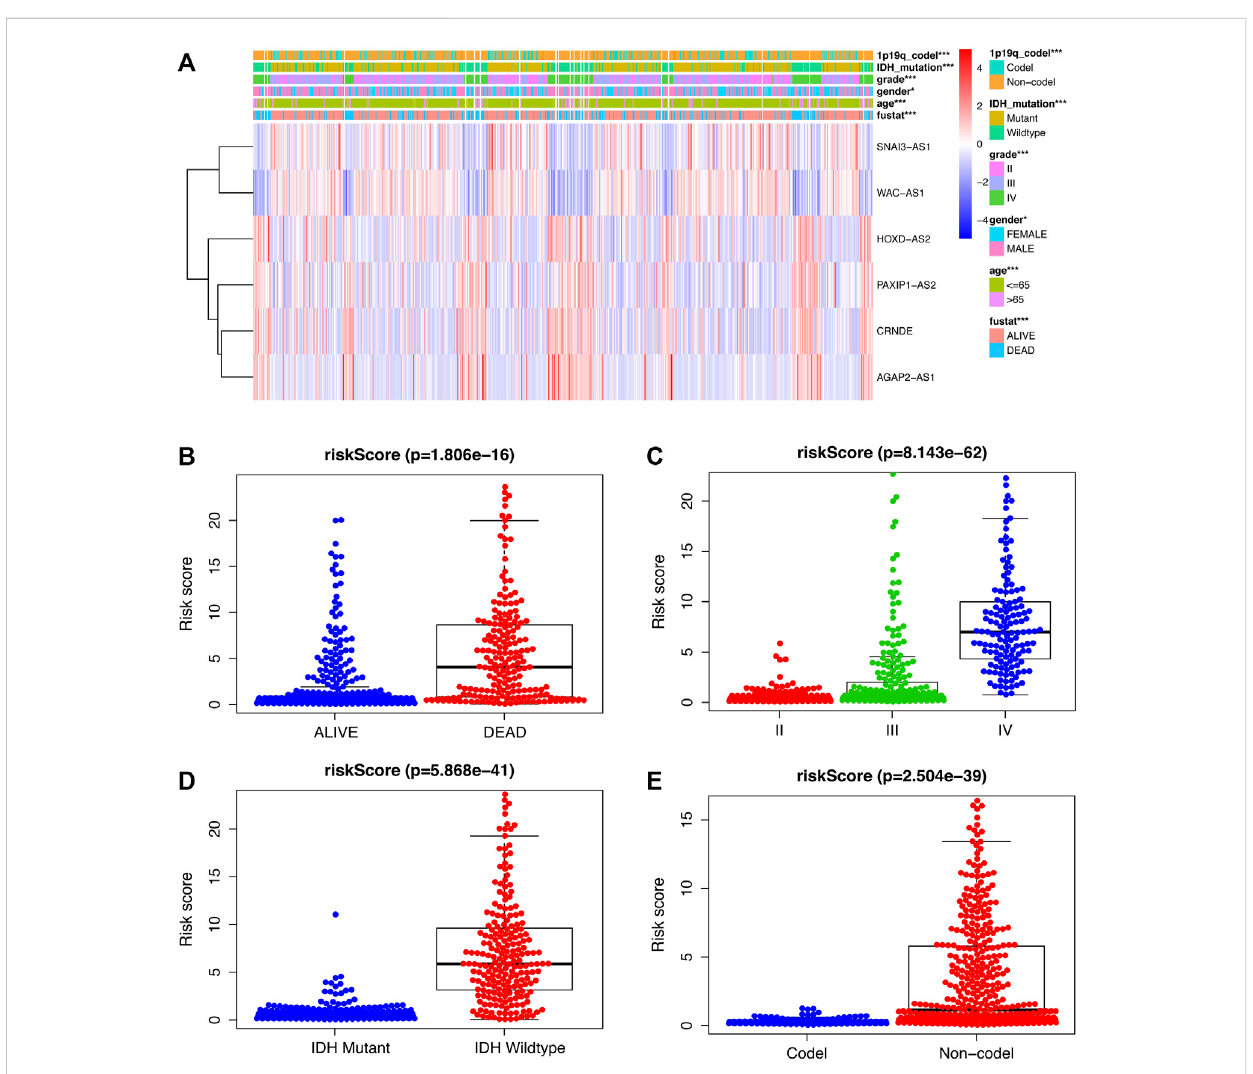
FIGURE 5 Examination of the link between SRlncRNAs and clinicopathological factors. (A) The heatmap suggests that IDH mutation status, 1p19q codeletion status, grade, age, and survival status are signi fi cantly different in different groups. (B,C) The scatter diagrams indicate that survival status and grade are positivewithahigher-riskscore. (D,E) ,Thescatter diagramsindicatethatIDHmutationstatusand1p19qcodeletionstatusarepositivelycorrelatedwitha signi fi cantly lower riskscore. * p < 0.05; ** p < 0.01; *** p < 0.001; ns, non-signi fi